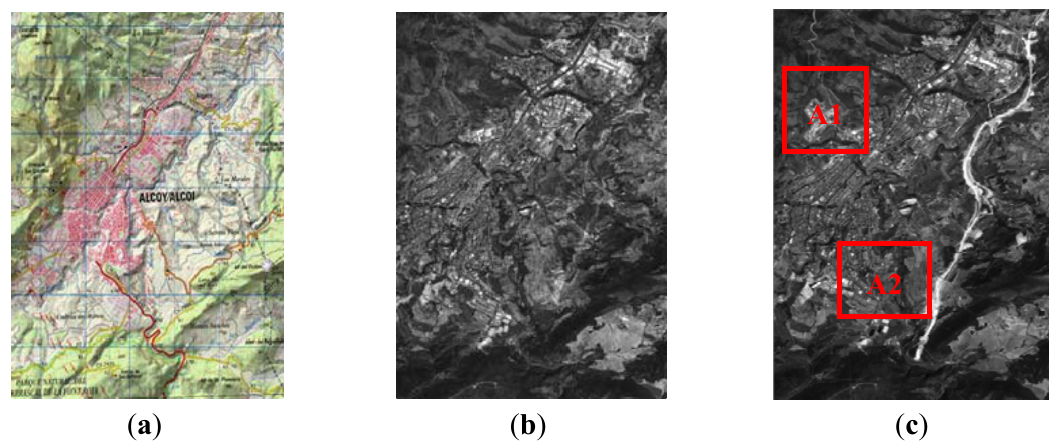
Figure 1. Study Area, ( a ) 1/50000 Official Cartography ( © IGN-SPAIN, 2005); ( b )